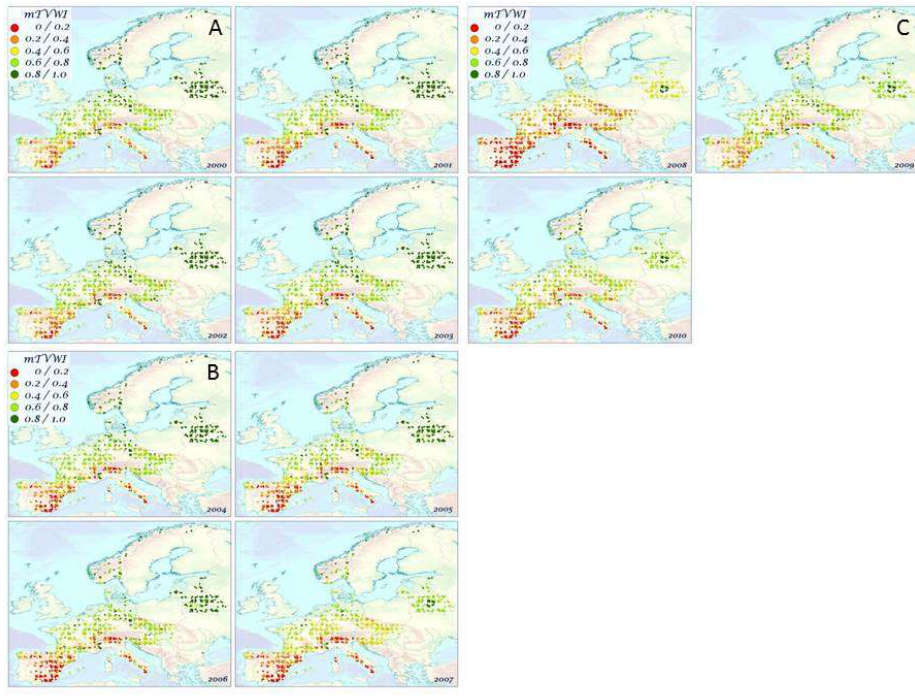
Figure 2. Spatial distribution of the mTVWI values over the time period 2000–2010. The points show ICP Forests level I sites.